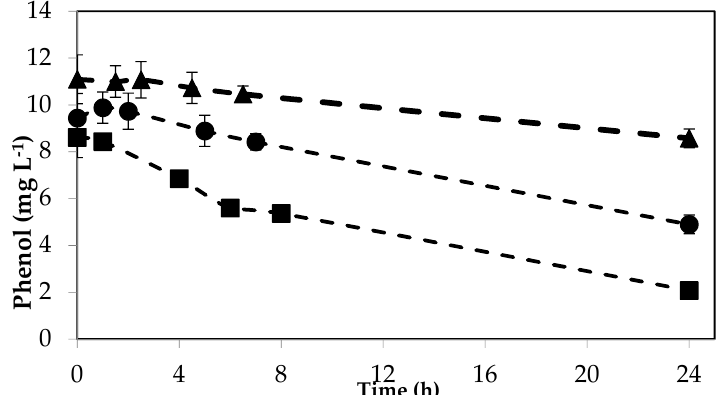
Figure 1. Phenol transformation with free enzyme ( ■ ), Tv immobilized onto fsNPs ( ▲ ), and onto FeO-2206W ( • ) over 24 h at pH 7.